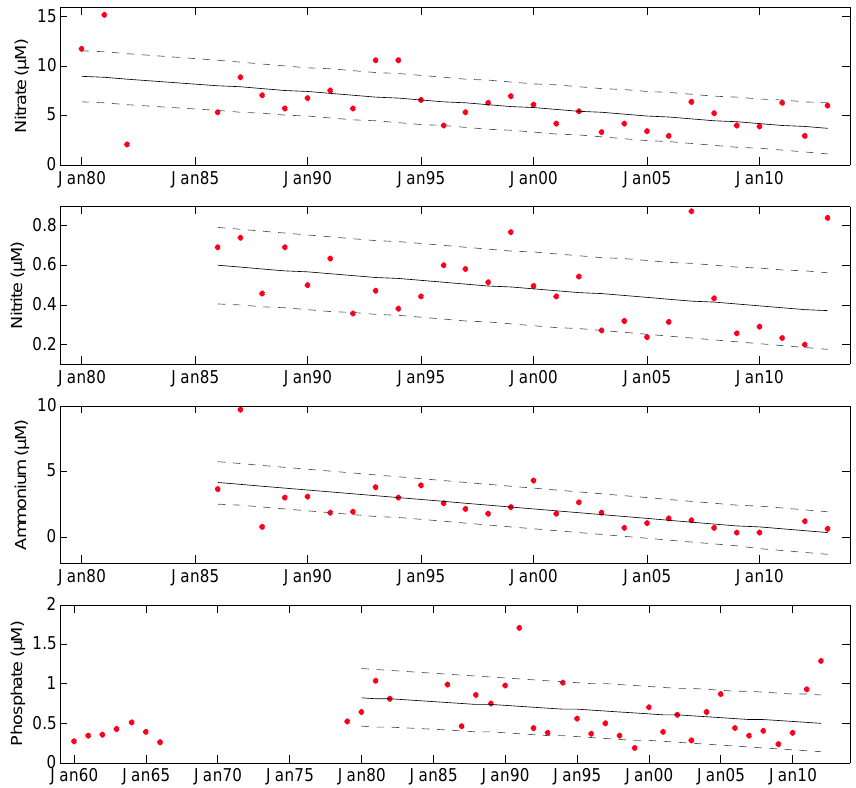
Figure 5. Average winter concentration (December-January-February, DJF, red dots) of nutrients at the Boknis Eck time series station, as well as linear decreasing trends (solid line represents the linear trend, broken lines the 95% confidence interval). Note the different x axis for phosphate.